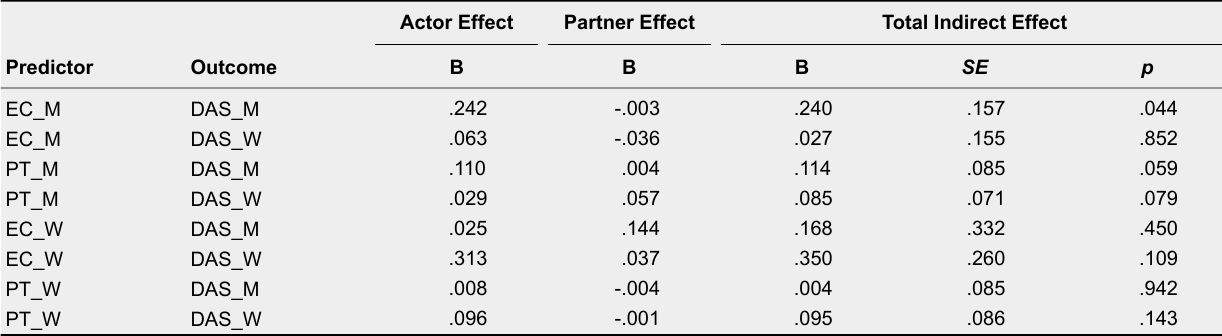
Dyadic Indirect Effects of Dyadic Empathy on Relationship Satisfaction